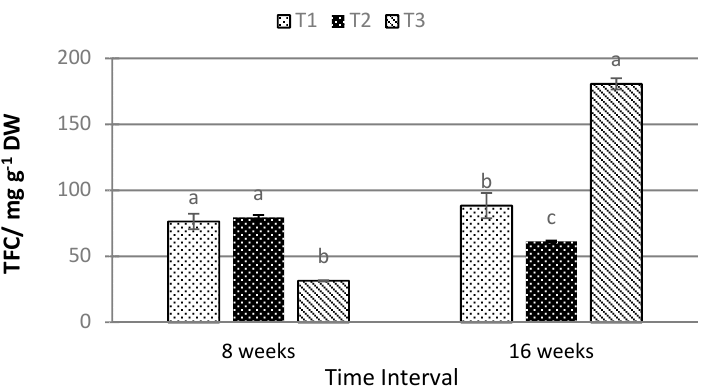
Figure 6. Effects of different shade levels on the total flavonoid content of P. minus (data are means of treatments, N = 36; Rep = 3; Control, T1 = 0% Shading; T2 = 50% Shading and T3 = 70% Shading; DW = Dry Weight). Means with different letters on top of each bar are significantly different at p ≤ 0.05.